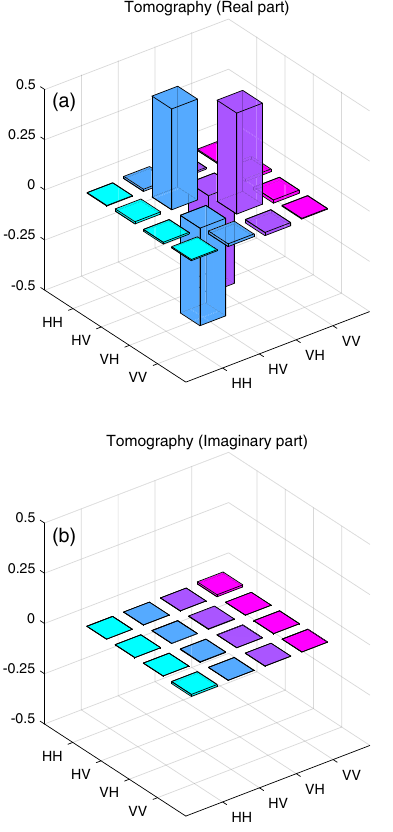
FIG. 4. Tomography of the produced two-photon state. The real and imaginary components are demonstrated in panels (a) and (b), respectively.